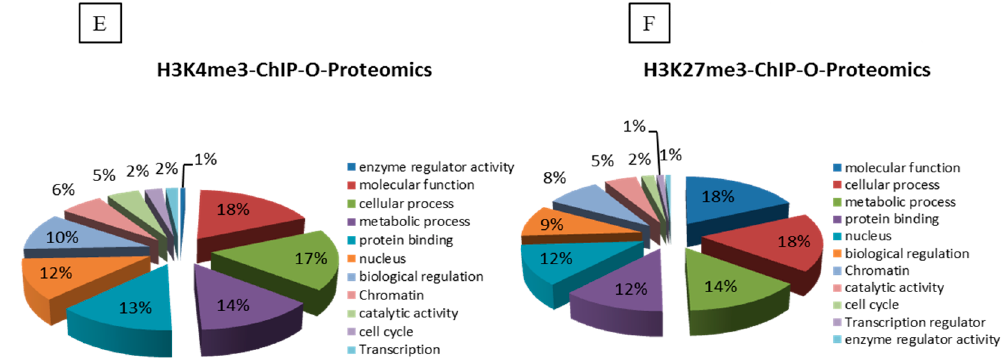
Figure 1. ( A ) Schematic overview of Chromatin Immunoprecipitation-O-Proteomics (ChIP-O-Proteomics) experimental steps. Differentiated and polarized Caco-2 cell monolayers were incubated with MPA (10 µ M) or DMSO for 72 h. Sheared chromatin having an active (H3K4me3) or repressive histone modification mark (H3K27me3) was precipitated using antibodies, anti-H3K4me3 or anti-H3K27me3, respectively. IgG was used as a background. Each sample was aliquoted into two portions. One portion was used for DNA-based promoter activity using real-time PCR. The other portion was used to identify and quantify promoter binding proteins using mass spectrometry. Three biological replicates, each one with at least two technical replicates, were performed for each group; ( B , C ) ChIP-DNA was subjected to real-time PCR with a specific primer pair of the MLCK promoter region. Each bar represents abundance or depletion of the activation mark (H3K4me3) and/or repression mark histone mark (H3K27me3) in the promoter of the MLCK gene. Data is presented as a fold change by taking the control as 1.0 and the error bar indicate means ± SEM. *** p < 0.001 compared with the control (DMSO); ( D ) Venn diagram show the number of identified proteins associated with an active promoter and repressive promoter following the subtraction of IgG precipitated proteins as background; ( E , F ) scaffold analysis of GO for the ChIP-O-Proteomics–identified proteins; ( E ) H3K4me3-associated proteins and ( F ) H3K27me3-associated proteins. Pie charts represent the percentages of the identified proteins belonging to different function groups.